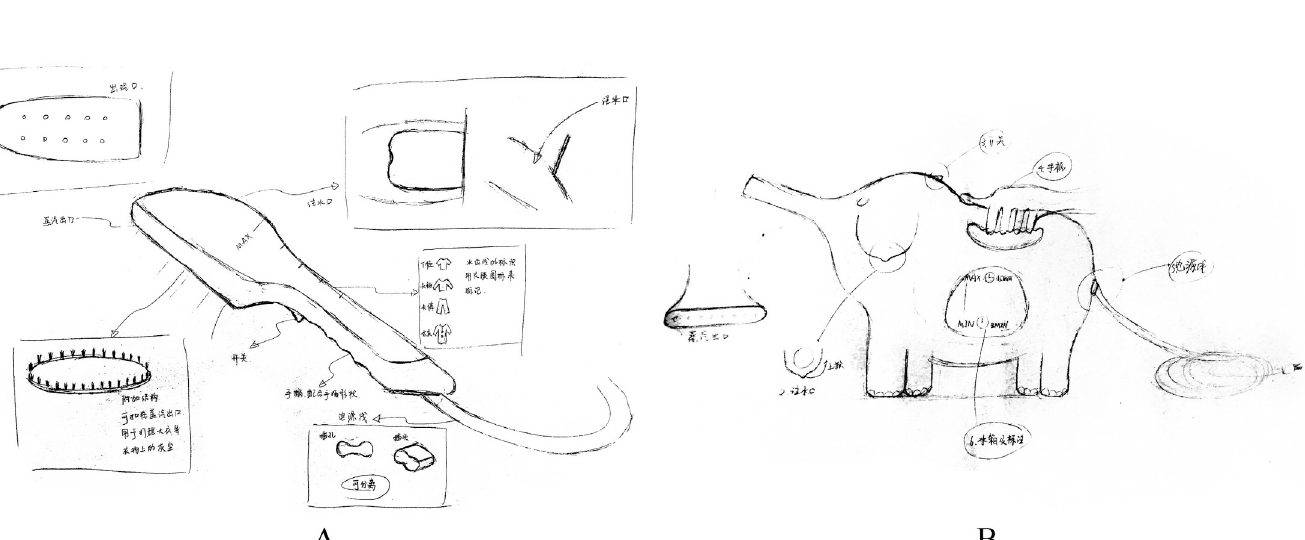
PLOS ONE | https://doi.org/10.1371/journal.pone.0254933 July 21, 2021 9 /